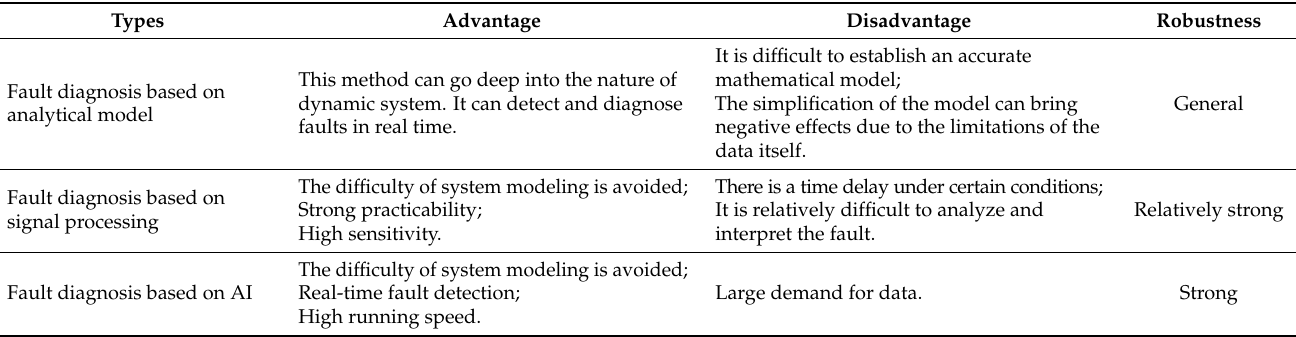
Table 1. Characteristics of various fault diagnosis